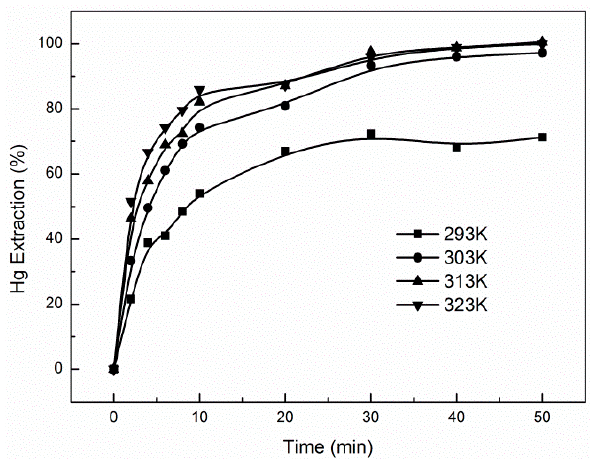
Figure 4. Effect of temperature on Hg extraction with Na 2 S 2 O 3 (Initially, 0.4 g HgO was mixed with 500 mL 0.01mol/L Na 2 S 2 O 3 solution).